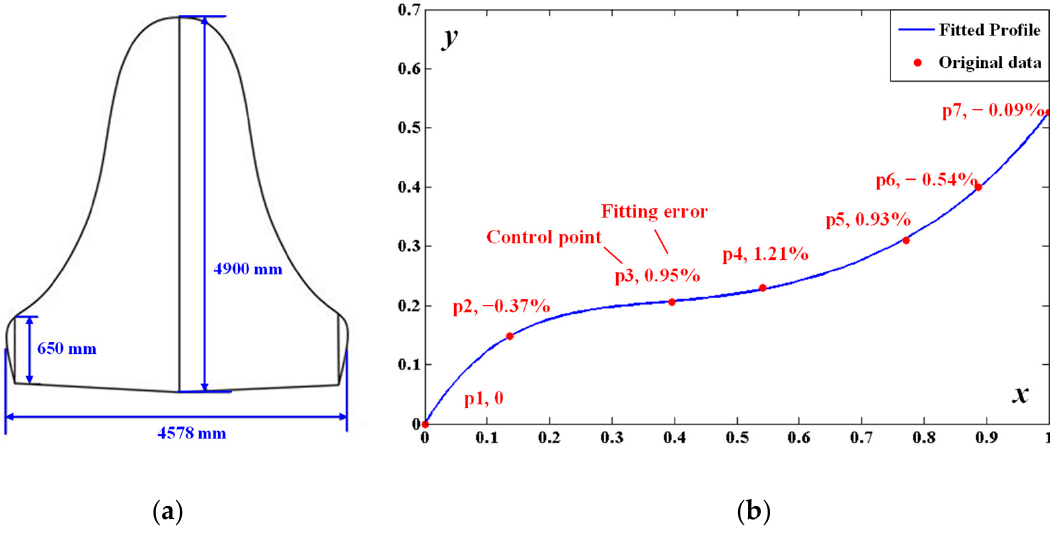
Figure 2. Profile of the hypersonic vehicle. ( a ) Planar graph; ( b ) Fitted